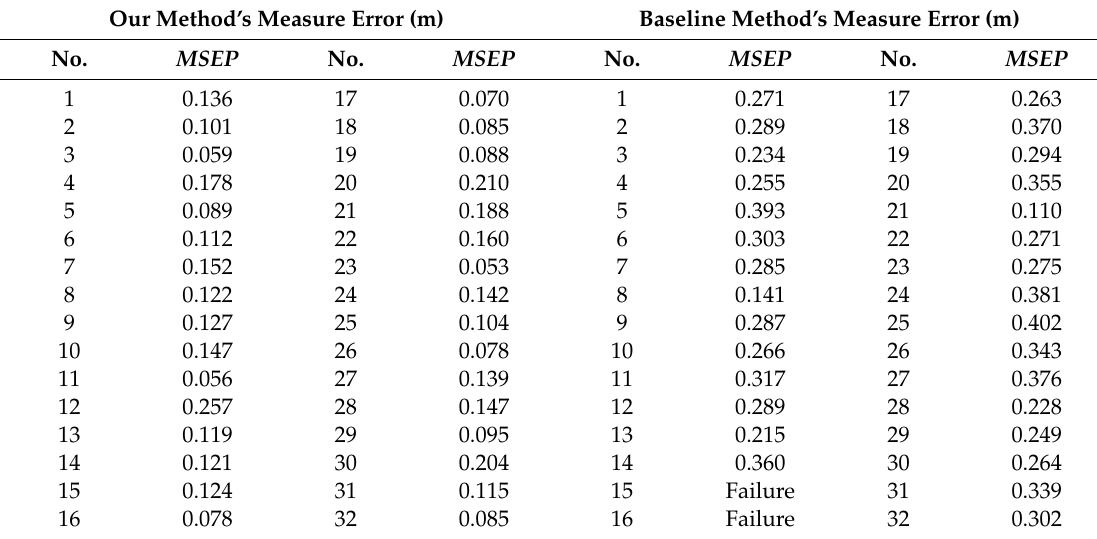
Table 7. Positioning accuracy comparison using images from a real conference